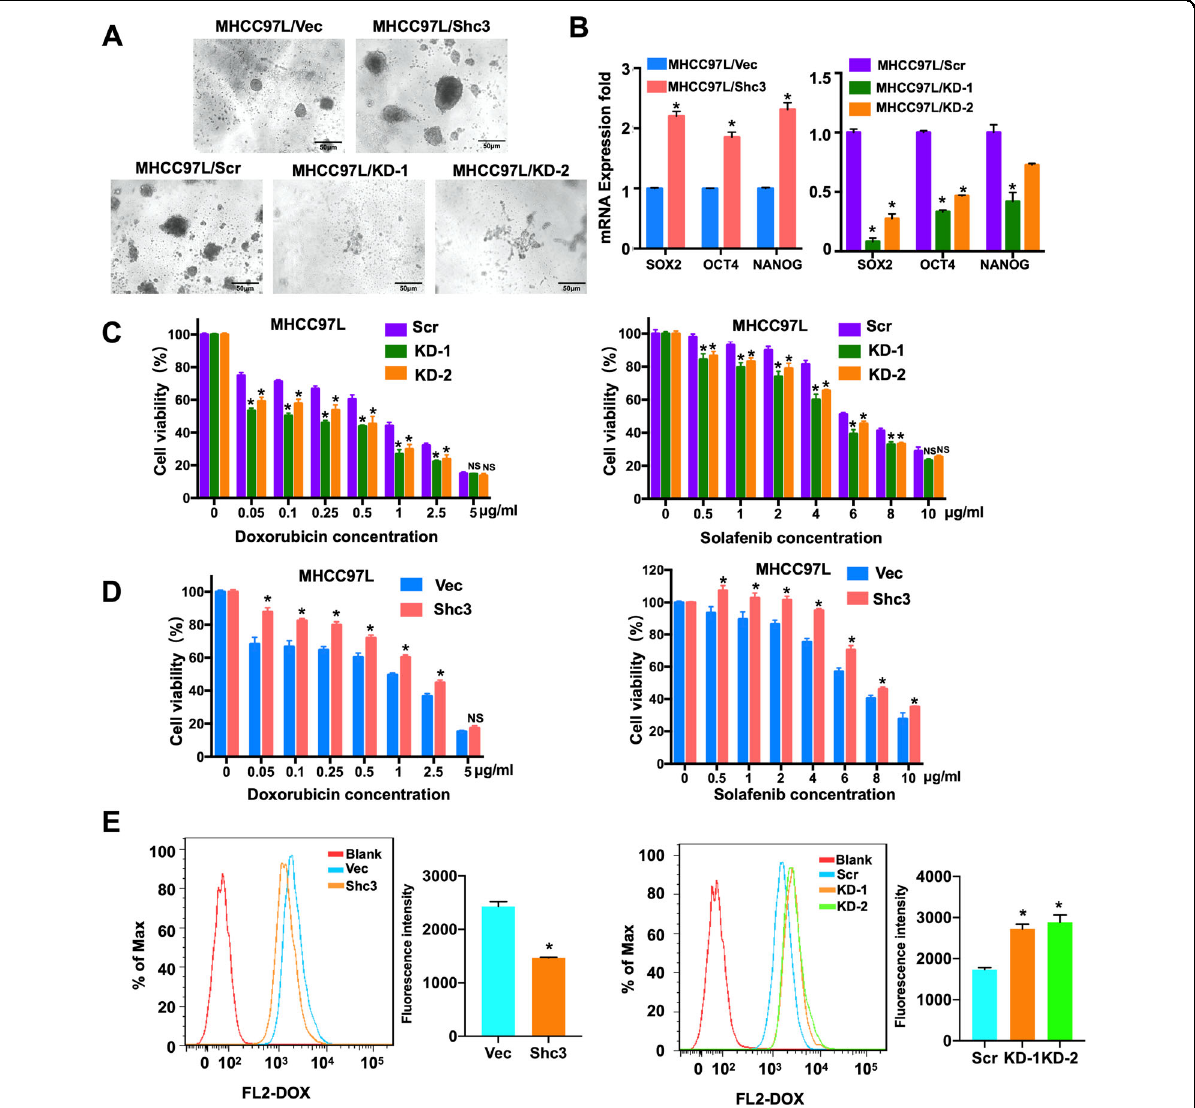
Fig. 3 Inhibition of Shc3 expression restores chemotherapeutic drug sensitivity of HCC cells. A Spheroid formation assay of MHCC97L/Shc3 or MHCC97L/KD and their control cells. A representative image is shown. B MHCC97L cells infected by lentivirus expressing Shc3 or shShc3 were collected and relative mRNA expression of SOX2, OCT4, and NANOG were examined by qRT-PCR. C Shc3 knockdown remarkably restored sensitivity of MHCC97L cells to doxorubicin (left) and sorafenib (right) in a dose-dependent manner. MHCC97L/KD or MHCC97L/Shc3 and their control cells were treated with drugs for 48 h. Cell viability was calculated using the CCK8 assay and compared with 100% viability non-treated cells. Data are shown as mean ± SD; n = 5; * P < 0.05 compared with control. D Overexpression of Shc3 signi fi cantly promoted drug resistance of MHCC97L cells to doxorubicin (left) and sorafenib (right). Data are shown as mean ± SD; n = 5; * P < 0.05 compared with control. E Flow cytometry analysis of MHCC97L/Shc3 (left) and MHCC97L/KD cells (right) after 4 h incubation with free doxorubicin. The comparison of intracellular fl uorescence intensities of different groups were shown. Data are shown as mean ± SD; n = 3. Error bars represent the mean ± SD (* P < 0.05 vs. control, by one-way ANOVA or Student ’ s t